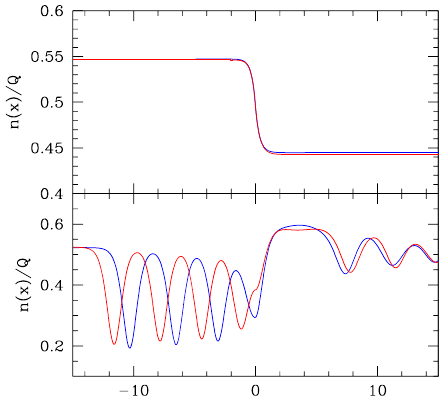
Figure 9. The two figures compare the long time behavior of the density when the usual (cubic) GPE is used (blue curves) in contrast with the modified (quintic) form of Equation (2) (red curves). In both cases, the same dimensionless coupling constant ˜ g = π 2 has been used. The profiles are qualitatively the same for both plots. The top plot shows a subsonic flow with k 0 = 0 and k F = π instead, is the case in which a sonic horizon form, i.e., k 0 = k F = π the case of a right moving fluid. All the curves refer to a time t = 20 m